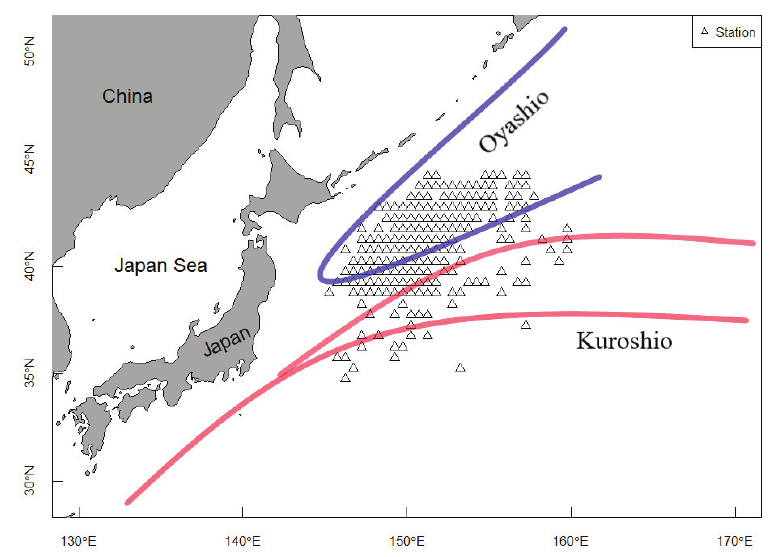
Figure 1. Location of fishing grounds for Pacific sardine in the NPO. The Oyashio cold current is represented using the blue lines and the Kuroshio warm current is shown using the red lines.